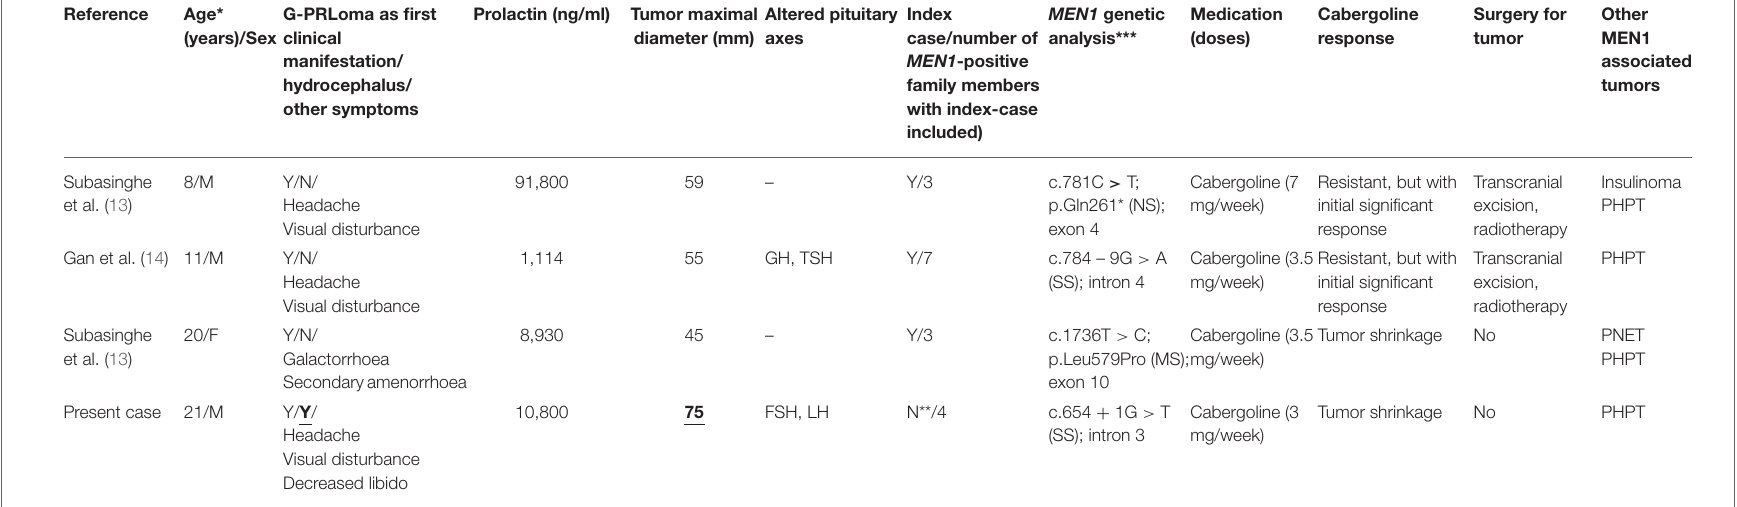
TABLE 2 | Main genetical and clinical findings and outcome of four young patients with MEN1-related giant prolactinoma.